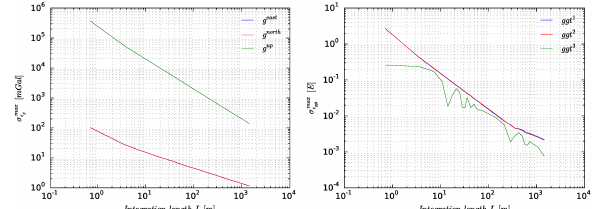
Figure 9: Effect of the AUV positioning uncertainty. At 1 km resolution, the uncertainty affecting g U is 2 order of magnitude greater than g E and g N . Components of the gravity gradient ten- sor are not affected by the AUV positioning uncertainty.